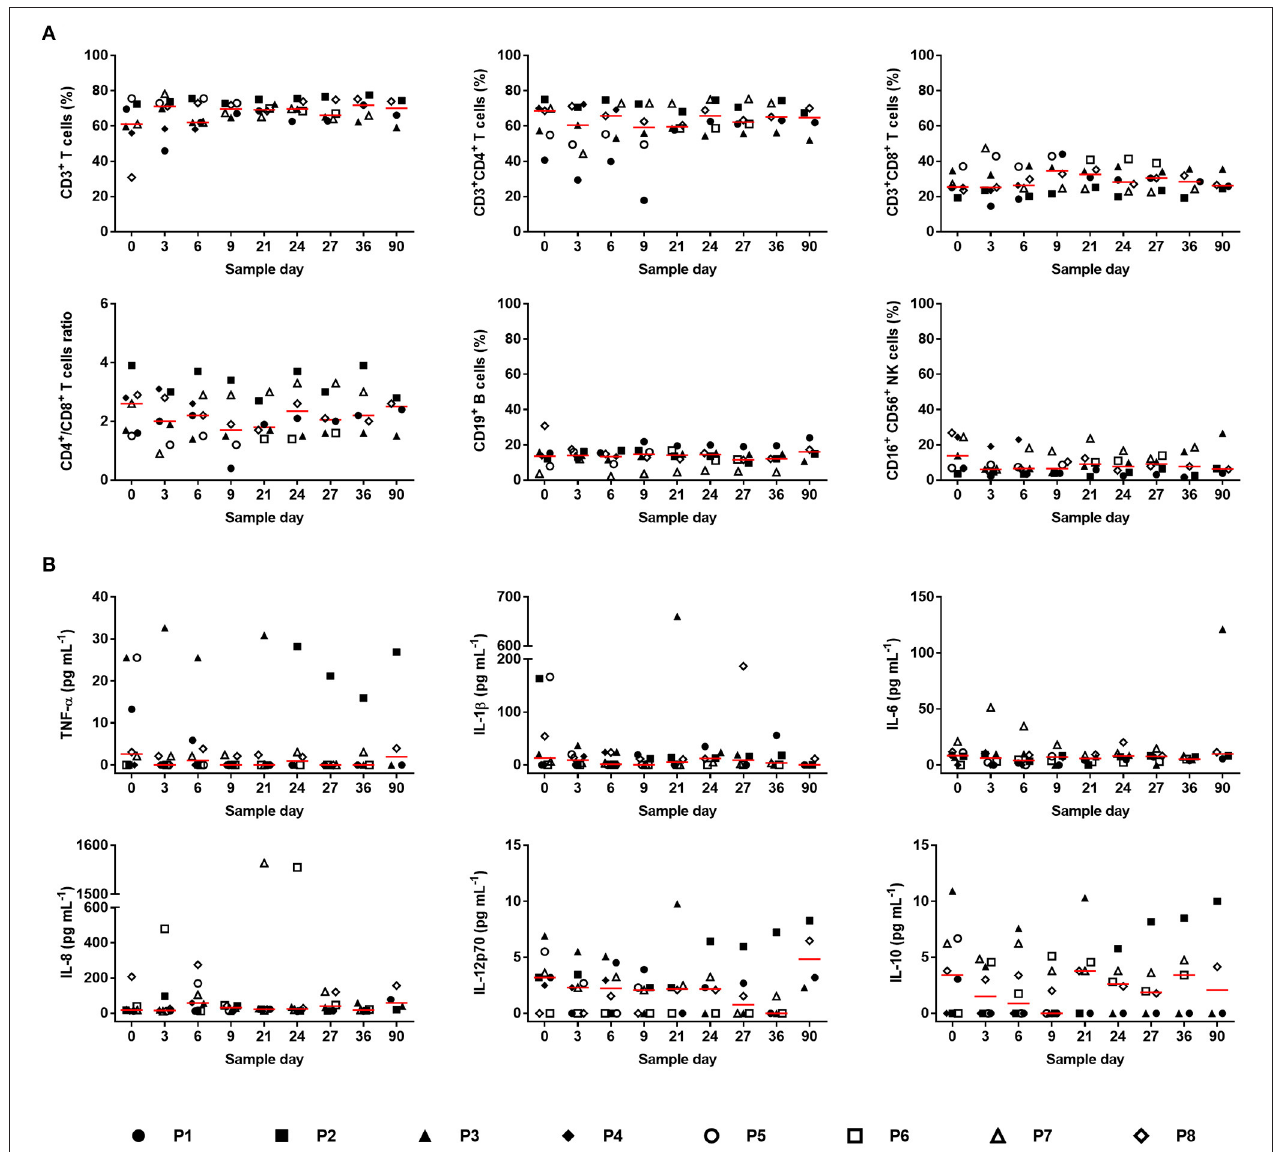
FIGURE 7 | Systemic inflammatory response. (A) Lymphocyte subpopulations were evaluated before (day 0) and after scaffold implantation: T-cells (CD3 + ), T-helper cells (CD3 + CD4 + ), Cytotoxic T-cells (CD3 + CD8 + ), ratio (CD4 + /CD8 + ), B-cells (CD19 + ) and NK cells (CD16 + CD56 + ). Values for each patient and median (red line) are presented. (B) The concentration of inflammatory cytokines was determined before (day 0) and after photosynthetic scaffold implantation: tumor necrosis factor alpha (TNF- α ), Interleukin-1 beta (IL-1 β ), Interleukin-6 (IL-6), Interleukin-8 (IL-8), Interleukin-12 (IL-12p70), and Interleukin-10 (IL-10). Values for each patient and median (red line) are presented. In (A) : N = 7 (day 0, 3, and 6), N = 6 (day 9, 21, 24, and 27), N = 5 (day 36), N = 4 (day 90). In (B) N = 8 (day 0, 3, and 6), N = 7 (day 9), N = 6 (day 21, 24, 27, and 36), N = 4 (day 90). Kruskal–Wallis test was used, and no significant differences were observed between